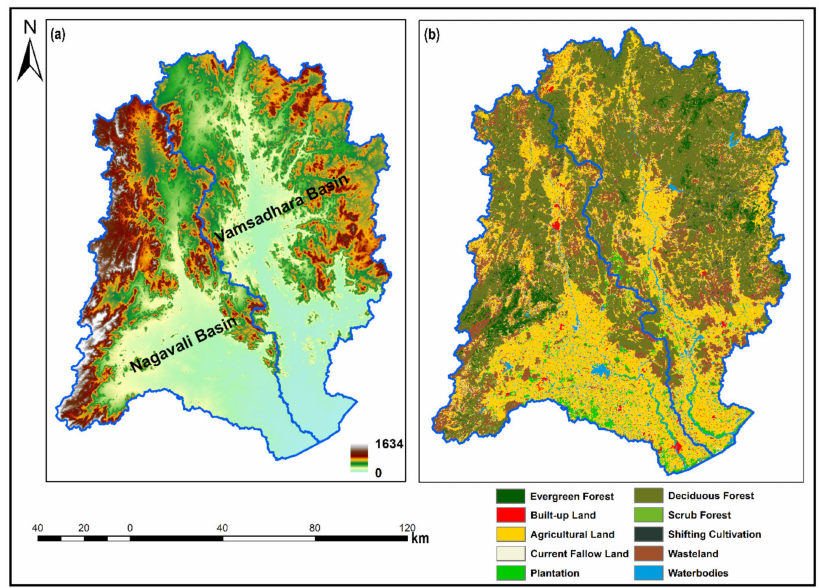
Table 2. Classification of land uses in the Nagavali and Vamsadhara basins. S. No. SWAT Code Class Name